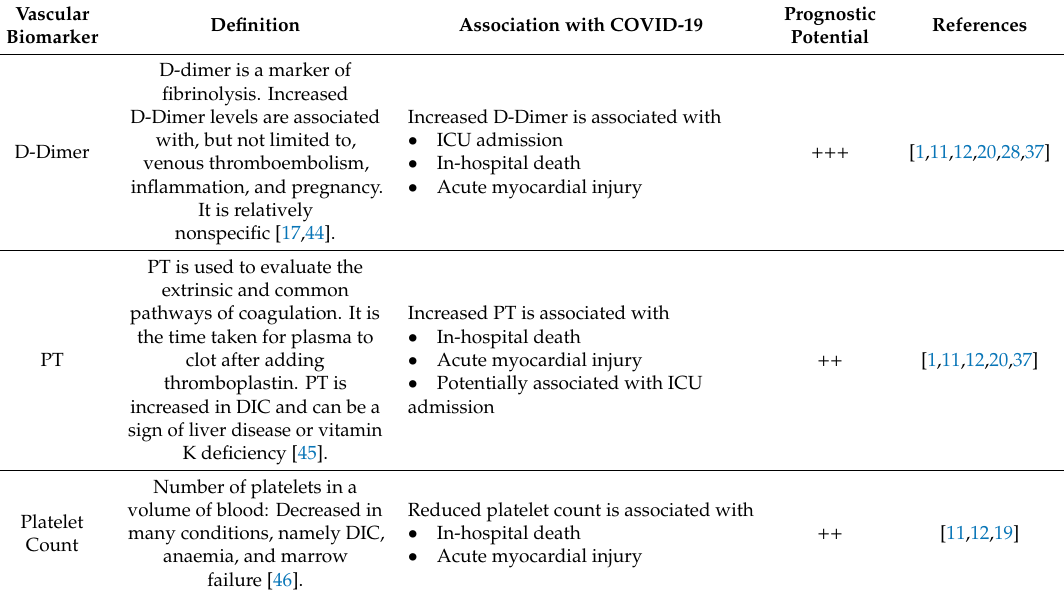
Table 2. A table highlighting the vascular biomarkers that may have prognostic value in COVID-19. Vascular